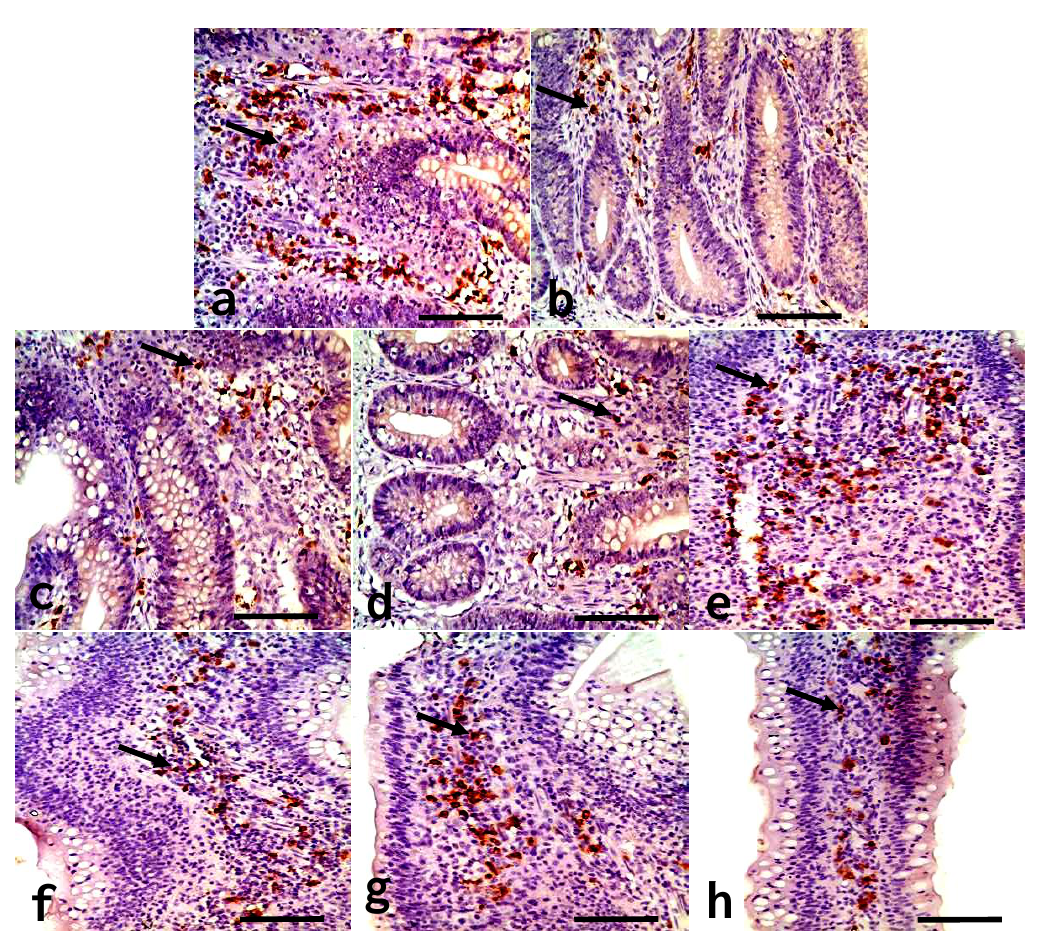
Figure 3. IgA + B cells in the crypts and lamina propria of villi in the jejunum at 42 days of age. ( a ) The jejunal crypts in the control group. ( b ) The jejunal crypts in the 300 mg/kg group. ( c ) The jejunal crypts in the 600 mg/kg group. ( d ) The jejunal crypts in the 900 mg/kg group. ( e ) The jejunal lamina propria in the control group. ( f ) The jejunal lamina propria in the 300 mg/kg group. ( g ) The jejunal lamina propria in the 600 mg/kg group. ( h ) The jejunal lamina propria in the 900 mg/kg group. (SABC, bar = 50